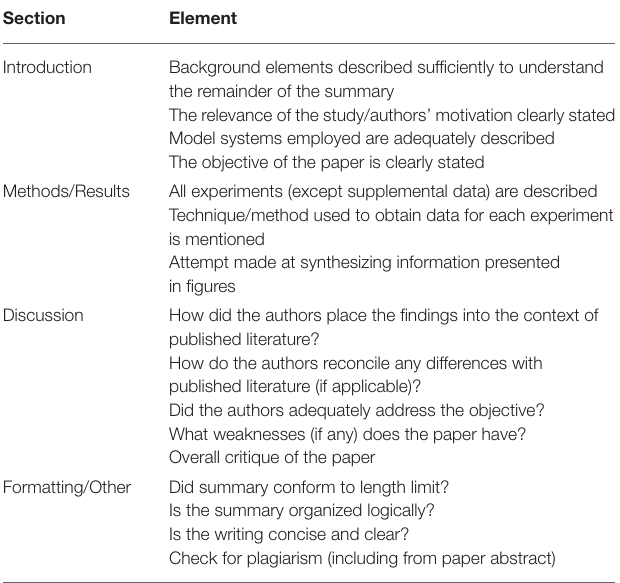
TABLE 3 | Checklist that can be used to develop paper-specific rubrics for grading paper